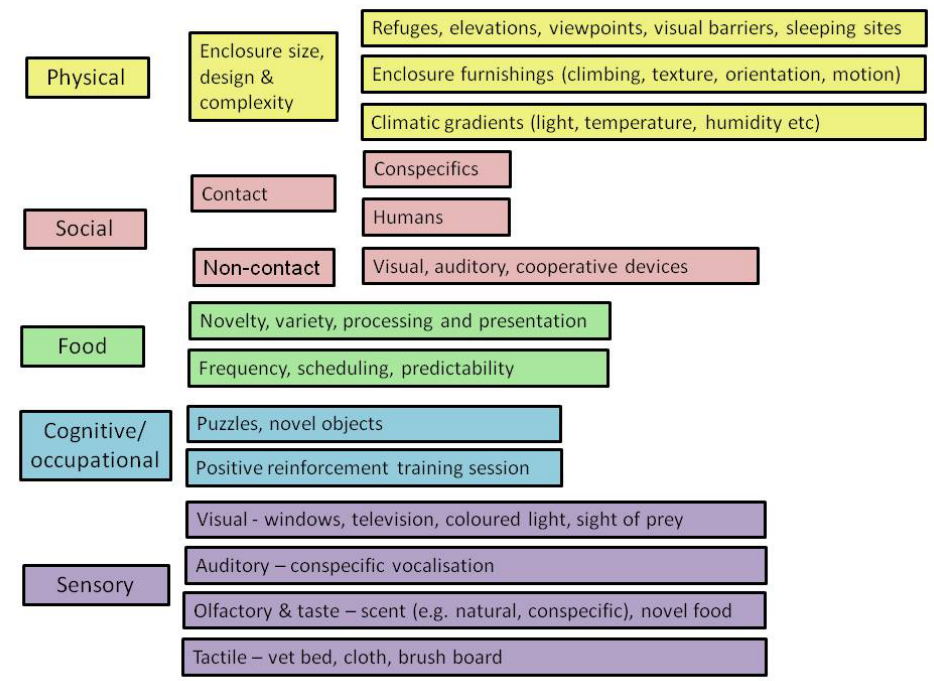
Figure 1. The categories of environmental enrichment for primates in laboratories (adapted from Bloomsmith et al. (1991) and The Shape of Enrichment